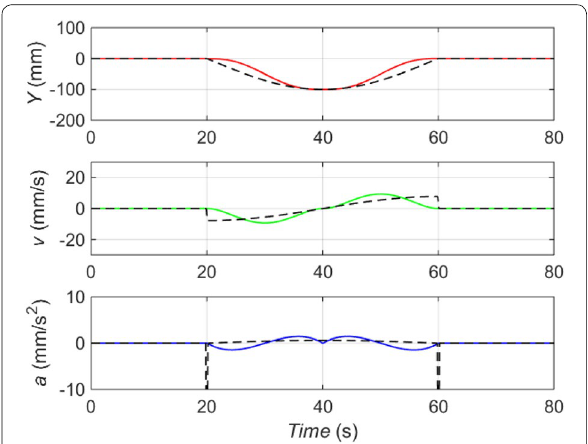
Figure 6 Position, velocity, and acceleration curves of fifth degree polynomial planning in the Z